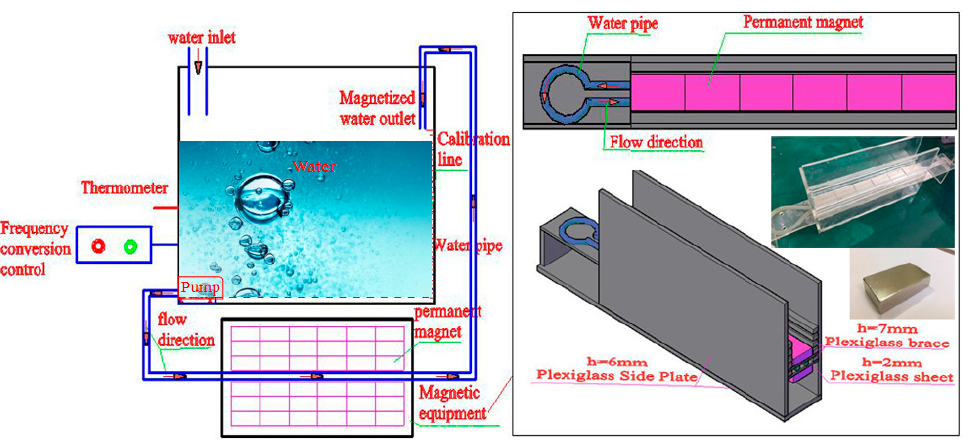
Figure 3. The magnetization system.